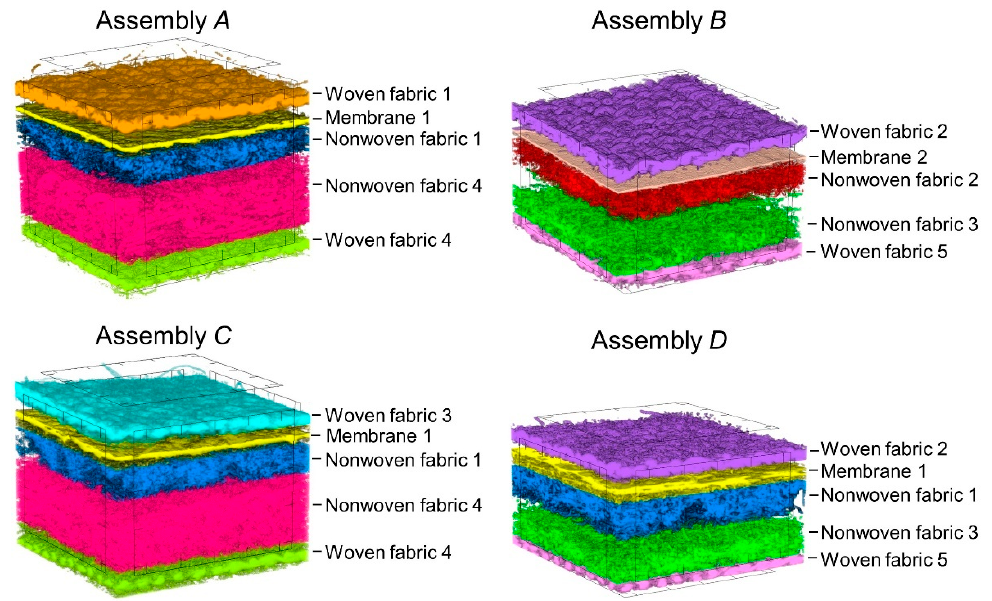
Figure 3. 3D micro-CT reconstructions of tested assemblies (dimensions: 4 mm × 4 mm).